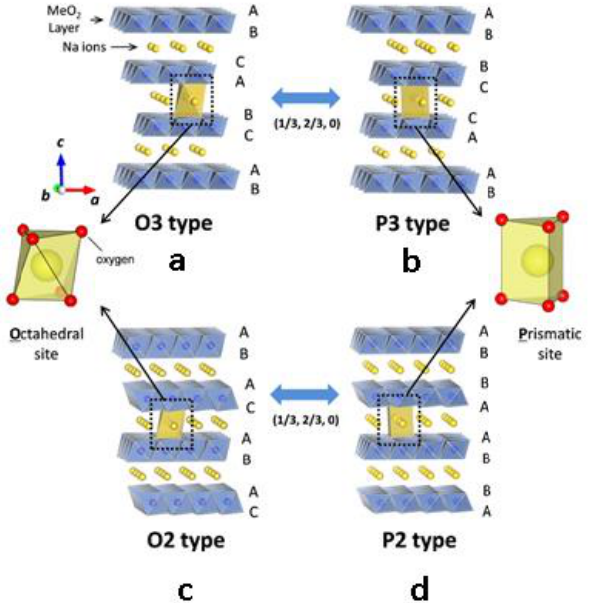
Figure 6. Schematic of the crystal structures for layered Na x MO 2 : ( a ) O3-type; ( b ) P3-type; ( c ) O2- type; ( d ) P2-type. Li/Na: yellow; transition metal: blue; O: red [158], with permission from IOP Publishing. 1. Li 2 MoO 3